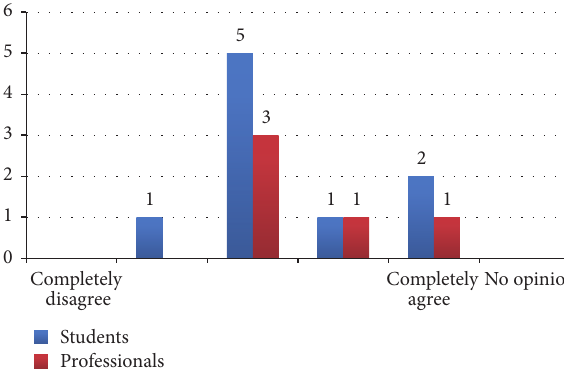
Figure 7: Statement: ECW/PUEA gives rise to a lot of new knowledge regarding possible use errors and usability